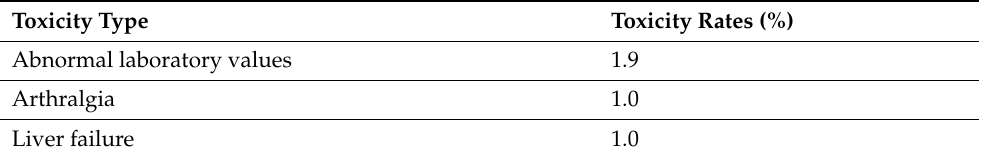
Table 3. Toxicity rates (grade ≥ 3) of adjuvant BRAF/MEK-treated stage III/IV melanoma patients in daily clinical practice (n =